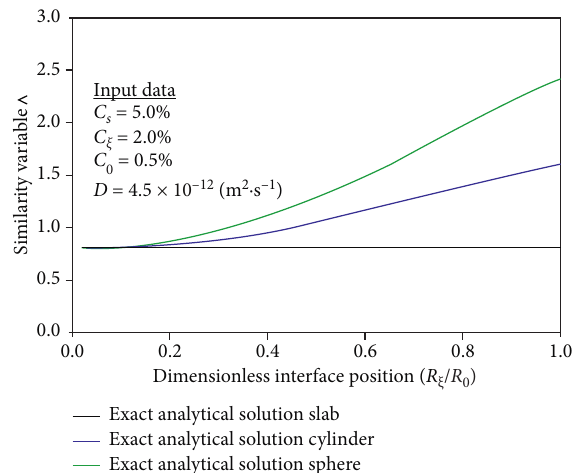
Figure 13: Comparison between numerical and analytical solu- tions for diffusion times as a function of one-dimensional corre- ) inward a slab, a cylinder, and a sphere. lation ( V / A 0